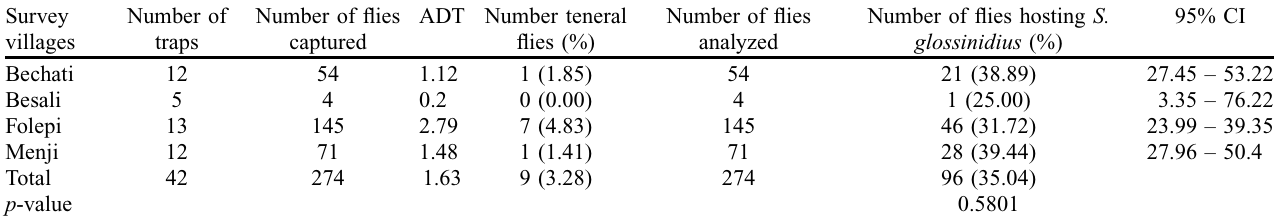
Number of flies hosting S.